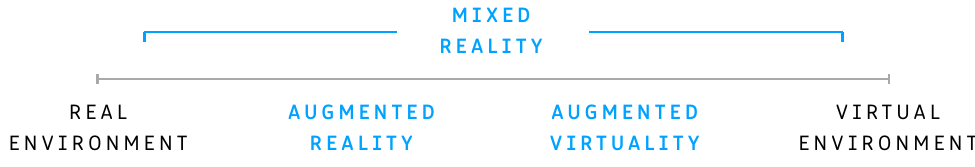
Figure 3. Milgram’s and Kishino’s reality–virtuality continuum. Adapted illustration based on the original diagram of Milgram and Kishino [55]. Prototypes can make use of the whole spectrum to make products, systems, and services